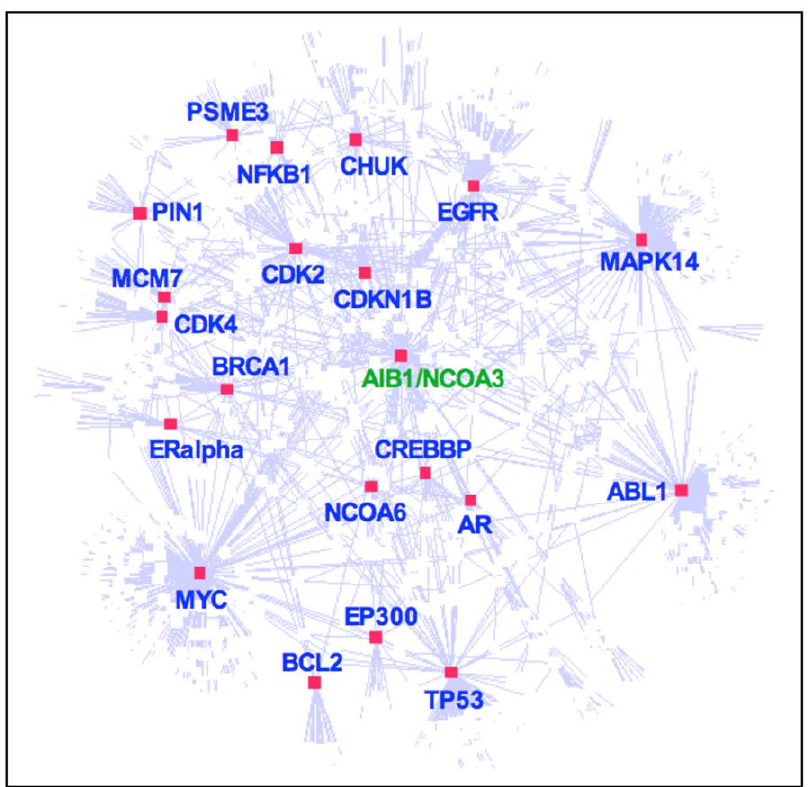
Figure 5. A global AIB1 interaction network showing the major hub proteins. Twenty-one hubs were identified using a cutoff of 20 node degrees. The full names of the respective gene symbols are provided in Table S8. Detailed nodes in the network are shown in Fig. S5.